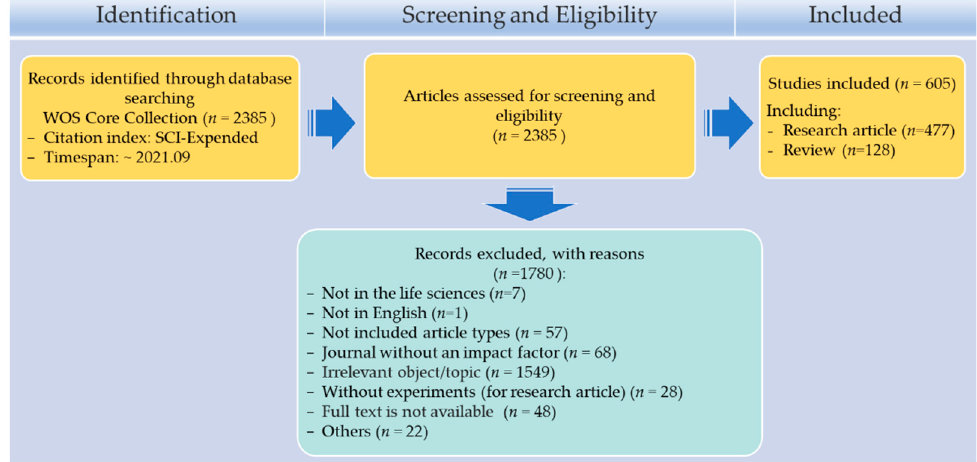
Figure 1. PRISMA flow diagram detailing the number of papers included at each stage and the reasons for removal. Please see Supplementary File S1 for detail.